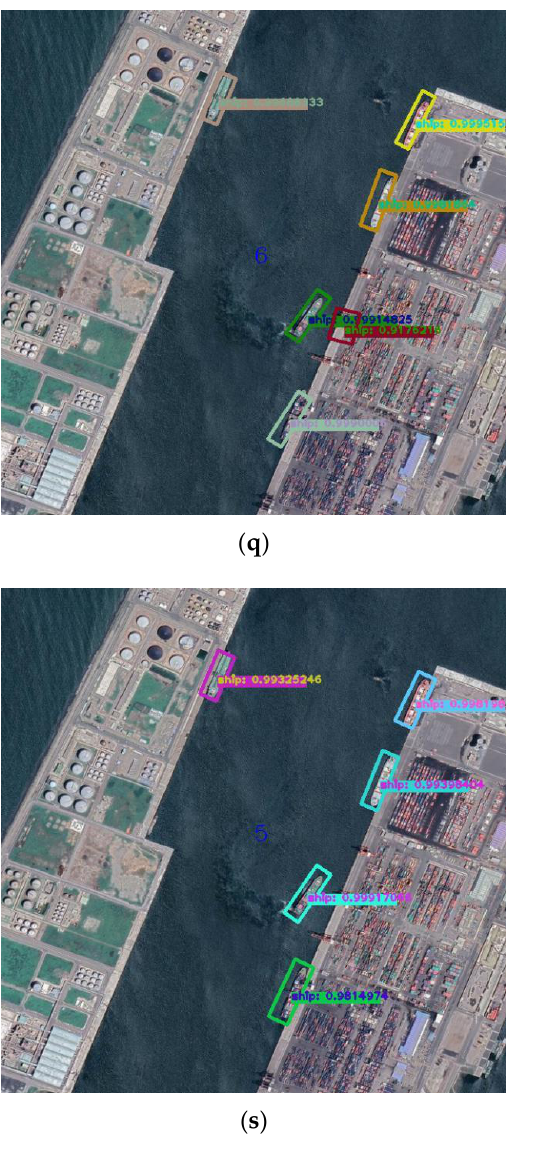
Figure 9. ( a , b ) are some of the results of 60 real images. ( c , d ) are some of the results of real images Figure 9 . ( a ) and ( b ) are some of the results of 60 real images. ( c ) and ( d ) are some of the results of real with noise perturbation. ( e , f ) are some of the results of real images with flipping. ( g , h ) are some images with noise perturbation. ( e ) and ( f ) are some of the results of real images with flipping. ( g ) of the results of real images with rotation. ( I , j ) are some of the results of real images with flipping and ( h ) are some of the results of real images with rotation. ( i ) and ( j ) are some of the results of real and rotation. ( k , l ) are some of the results of the 60 simulated images. ( m , n ) are some of the results images with flipping and rotation. ( k ) and ( l ) are some of the results of the 60 simulated images. ( m ) of simulated images with noise perturbation. ( o , p ) are some of the results of simulated images with and ( n ) are some of the results of simulated images with noise perturbation. ( o ) and ( p ) are some of flipping. ( q , r ) are some of the results of simulated images with rotation. ( s , t ) are some of the results of the results of simulated images with flipping. ( q ) and (r) are some of the results of simulated images simulated images with flipping and with rotation. ( s ) and ( t ) are some of the results of simulated images with flipping and rotation.